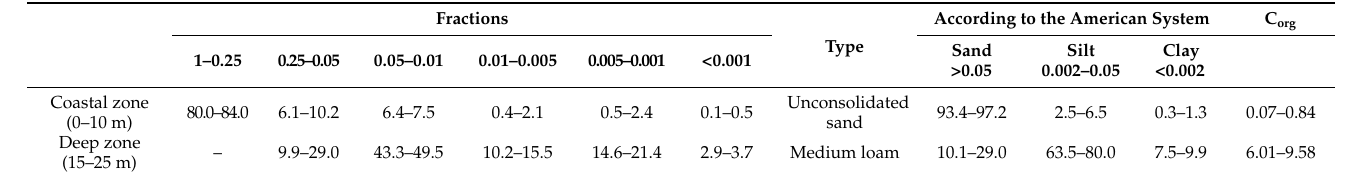
Table 3. Content of predominant fractions and organic carbon in BS samples from Lake Gusinoe (% of the sum of frac- tions).